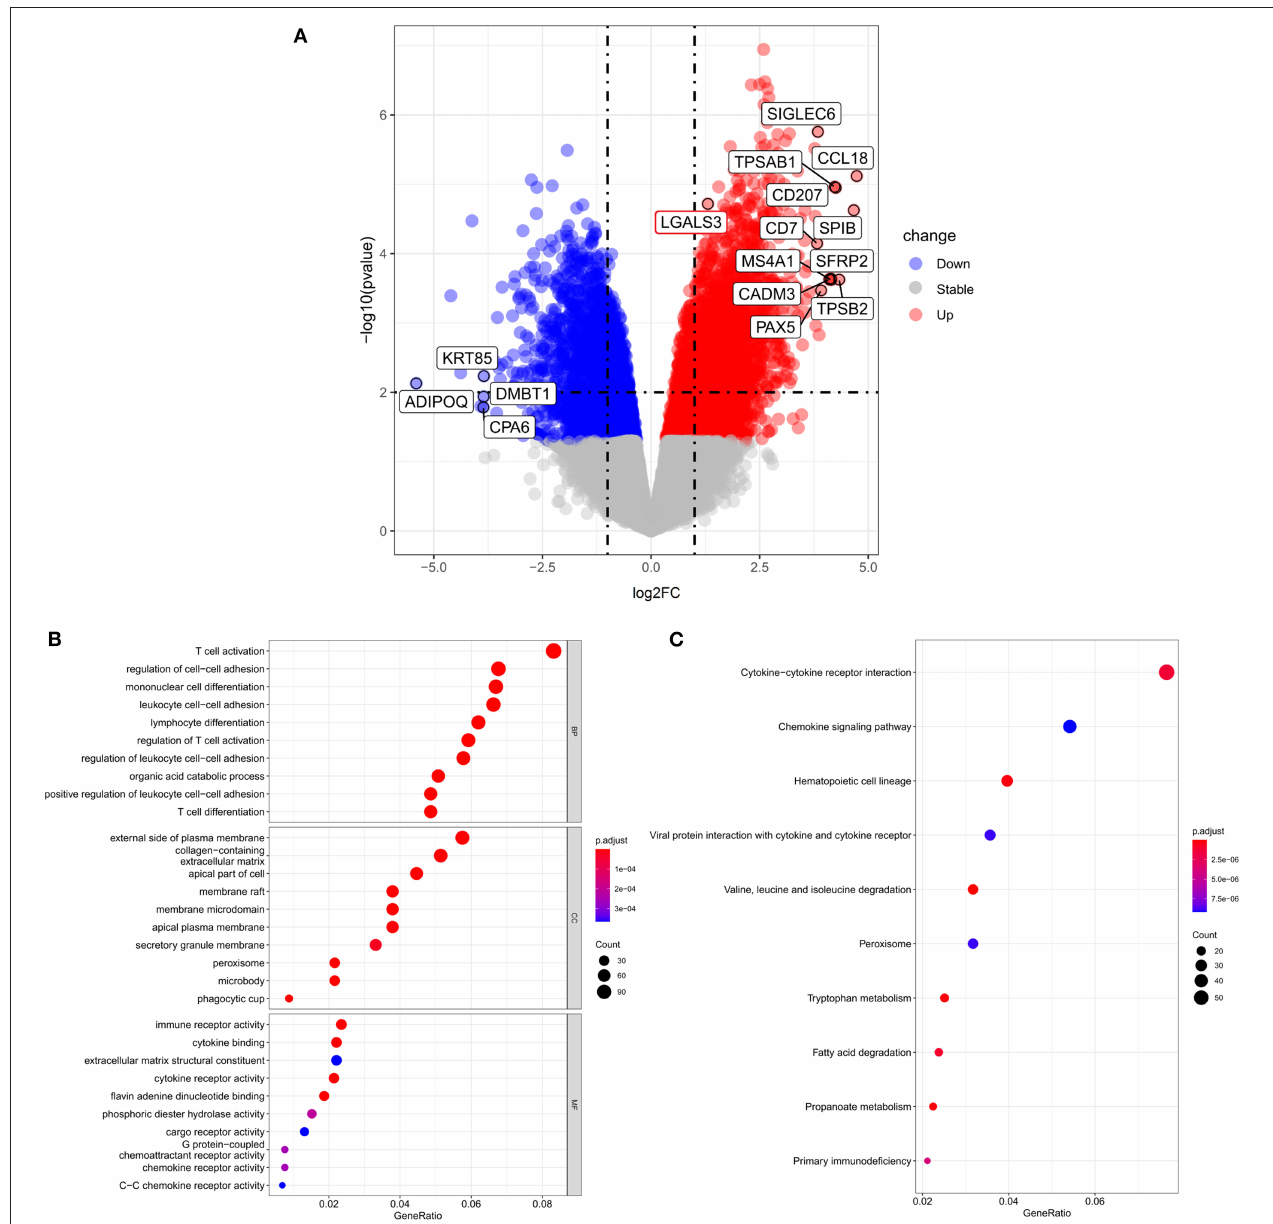
FIGURE 4 | Volcano plots and GO and KEGG enrichment analysis according to RNA sequence analysis. (A) Volcano plot of differentially expressed genes between fibrotic groups and non-fibrotic controls. (B) The biological process, cellular components and molecular function identified from the GO and (C) KEGG enrichment analysis of the RNA sequencing. GO, Gene Ontology; KEGG, Kyoto Encyclopedia of Genes and